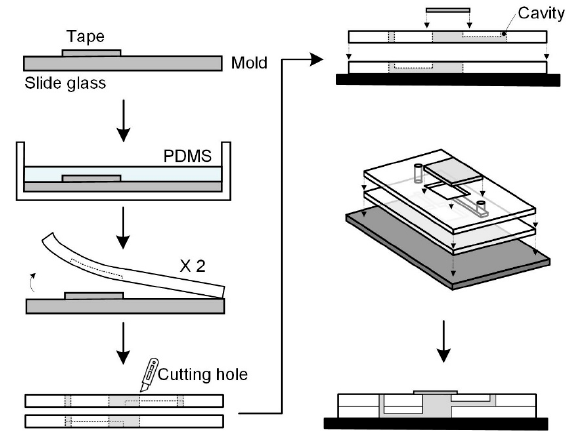
Figure 2. Fabrication of patterned microchannels using soft lithography.